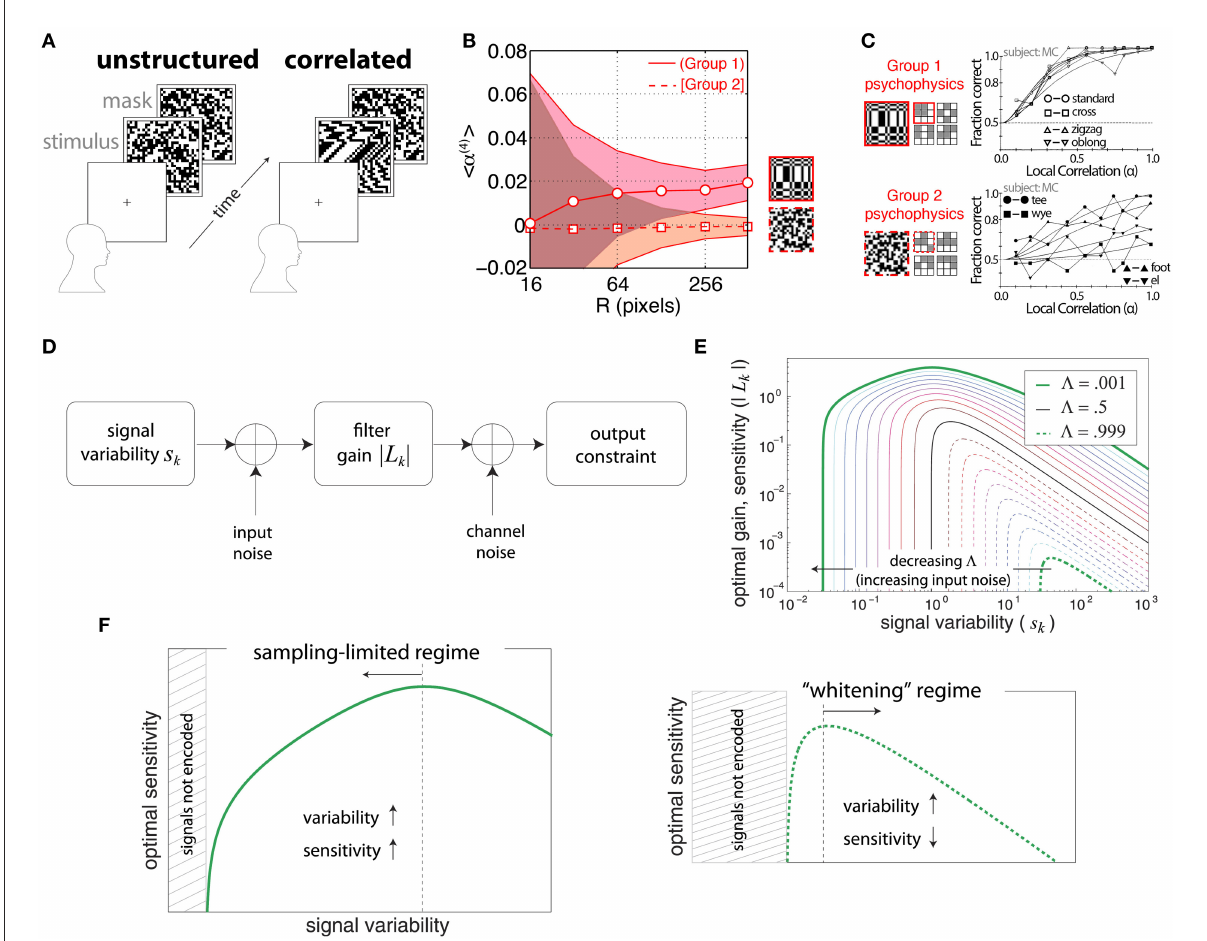
FIGURE1 Efficient coding relating natural-image statistics to psychophysics. (A) The forced-choice task from Victor and Conte (1991). After a cue, a subject is shown either an unstructured (Victor and Conte, 1991) texture half of the time, or a correlated texture. The subject was asked to distinguish between the structured and unstructured stimuli. (B) Average four-point correlations calculated for each of two kinds of glider (see C ) over a database of natural images. Group 1 correlations have an average that is statistically positive, while Group 2 correlations average close to zero even for large patches. Adapted from Tkaˇcik et al. (2010). (C) Psychophysics results for the same texture groups as in (B) . The x -axis shows the strength of the correlations. Group 1 textures have low discrimination thresholds, while Group 2 textures are hard to distinguish from unstructured noise even at the highest correlation levels. Adapted from Victor and Conte (1991) and used with permission from Elsevier. (D–F) Two regimes of efficient coding, depending on input and output noise. Adapted from Hermundstad et al. (2014). (D) The model that is being optimized. (E) Results of the optimization as a function of input noise. Note that higher gain leads to higher sensitivity assuming a fixed threshold on the amplified signal. Signal variability is the variance of the input signal. The parameter 3 measures the balance between input and output noise. Small 3 is the regime where input nose dominates, while large 3 is when output noise dominates. (F) (Left) The “variance predicts salience,” sampling-limited regime that was found to be relevant for texture perception in Hermundstad et al. (2014). (Right) The more familiar whitening regime of efficient